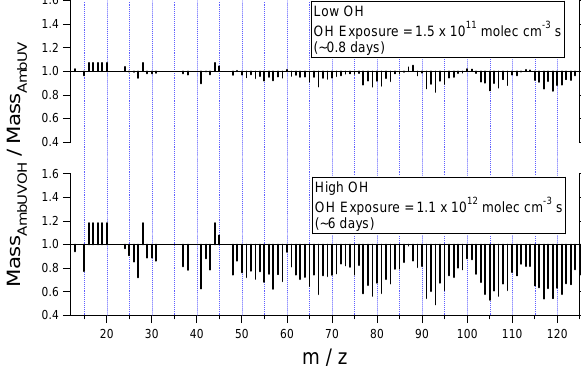
Fig. 5. Mass spectral changes due to OH oxidation for low and high OH exposures. Spectral changes are plotted as the ratio of spec- tra obtained at the AmbUVOH condition to the AmbUV condition. Individual spectra used to create this plot are shown in the Supple-